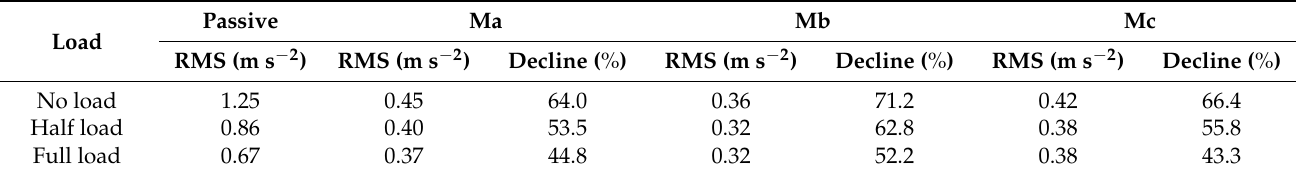
Figure 5. Time response comparison of body acceleration under different loads. Table 7. RMS values of body acceleration for time response to a random excitation under different